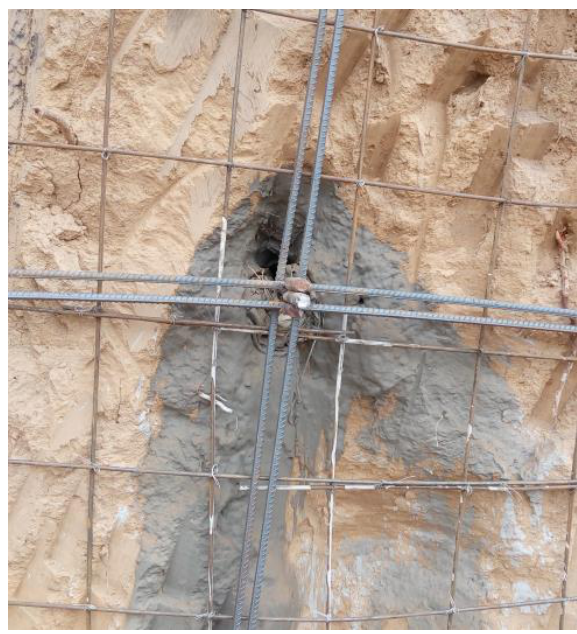
Figure 3. The enhancement configuration of facing. The designed value of the prestressing force of the anchor was 50 kN. The design parameters of the soil nails and prestressed anchors in different retaining structures are summarized in Tables 3 and 4.